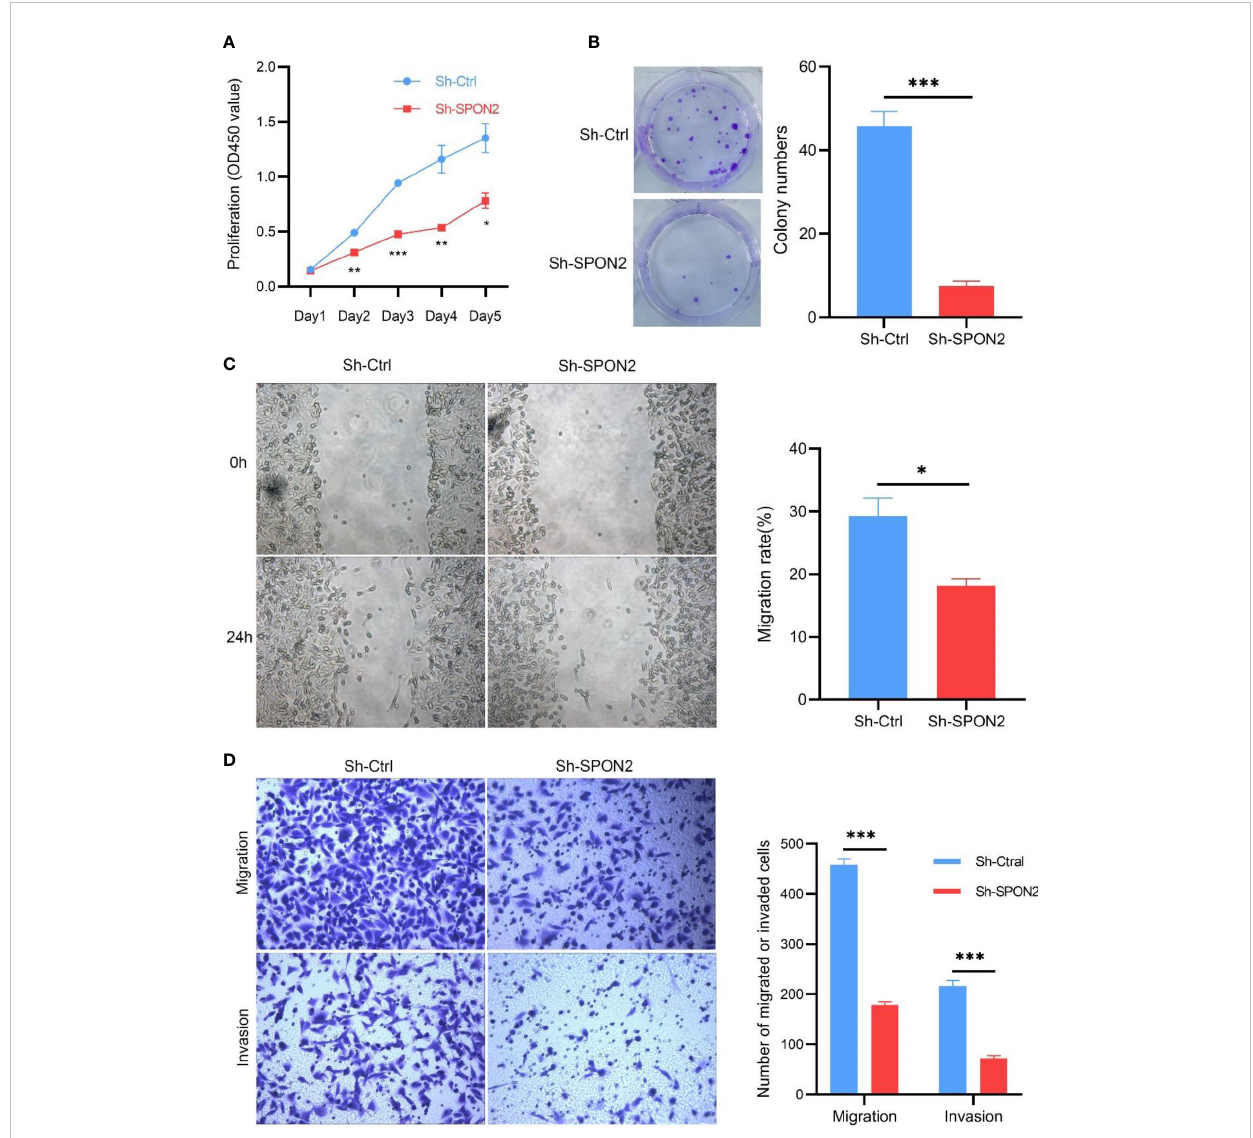
FIGURE 4 Knockdown of SPON2 inhibits proliferation, clone formation, migration, and invasion of MDA-MB-231 cells. (A) CCK8 showed that SPON2 knockdown inhibited the proliferative capacity of MDA-MB-231 cells. (B) Clonogenesis assays showed that SPON2 knockdown inhibited the clonogenic ability of MDA-MB-231 cells. (C) Scratch assay showed that SPON2 knockdown inhibited the migratory ability of MDA-MB-231 cells. Magni fi cation times: ×100. (D) Transwell migration and invasion assay showed that SPON2 knockdown inhibited the migration and invasion ability of MDA-MB-231 cells. Magni fi cation times: ×200. * P < 0.05, *** P <